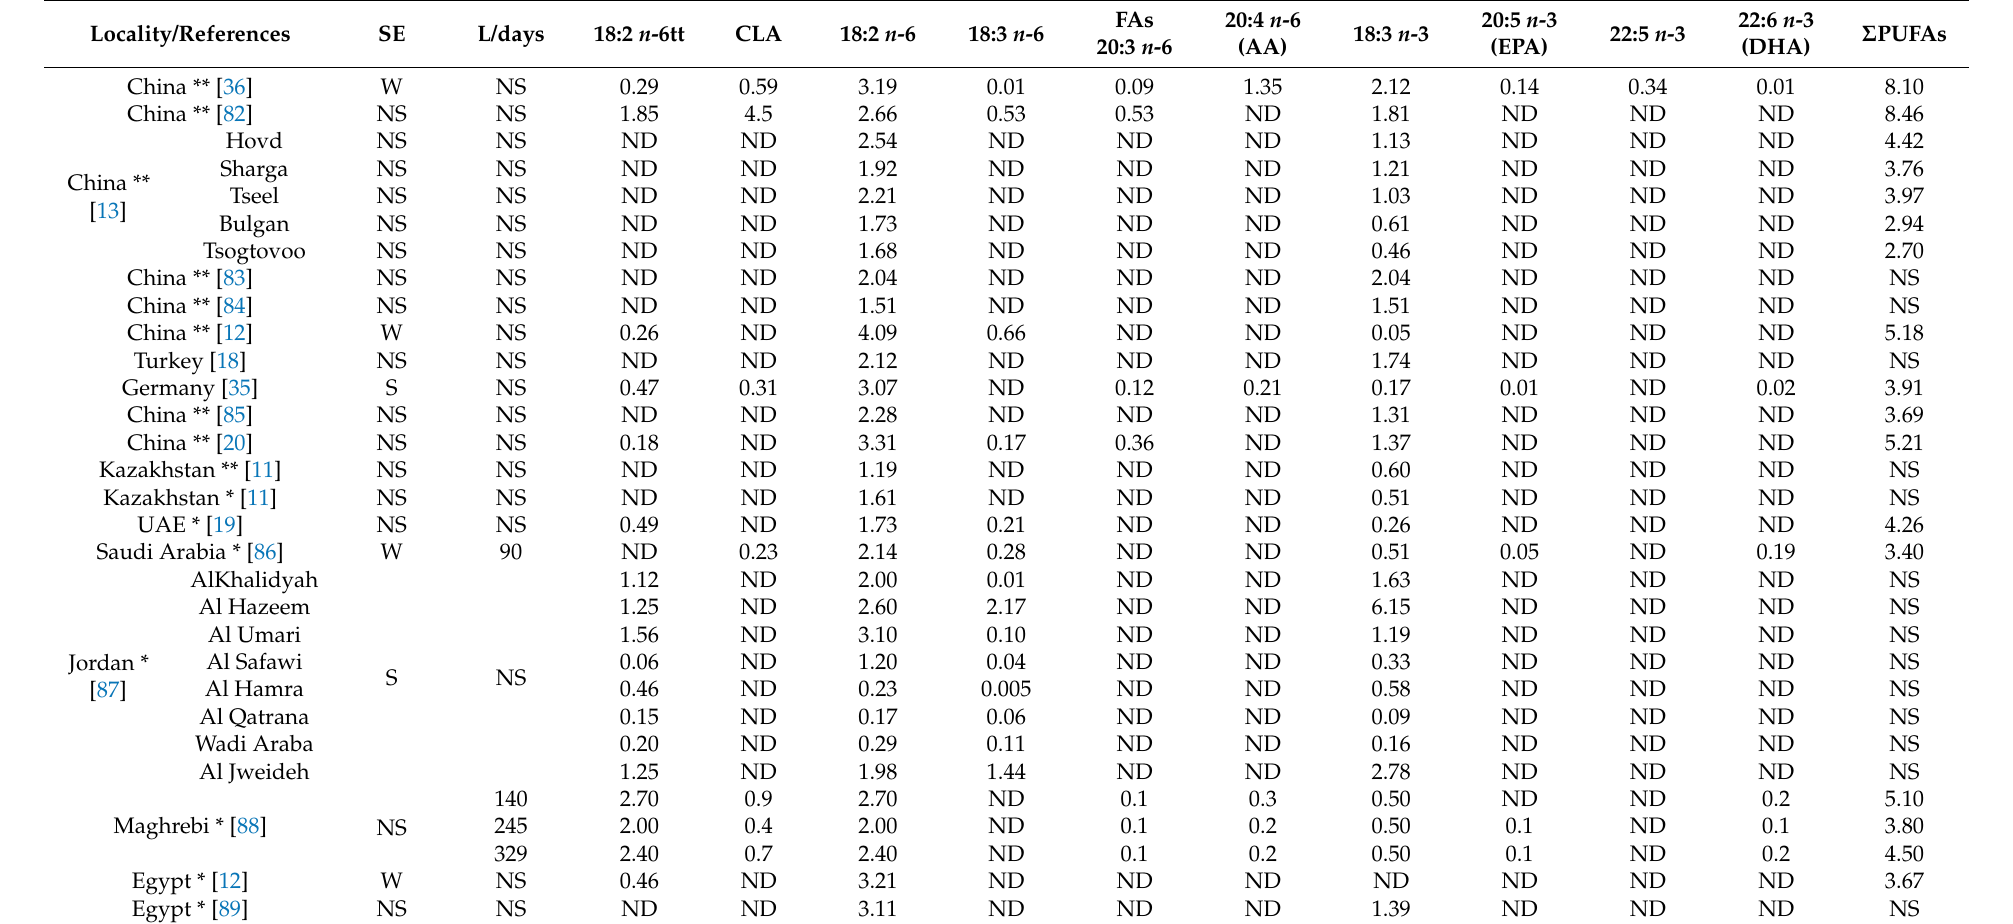
Table 2. Composition of polyunsaturated FAs in camel milk from four different